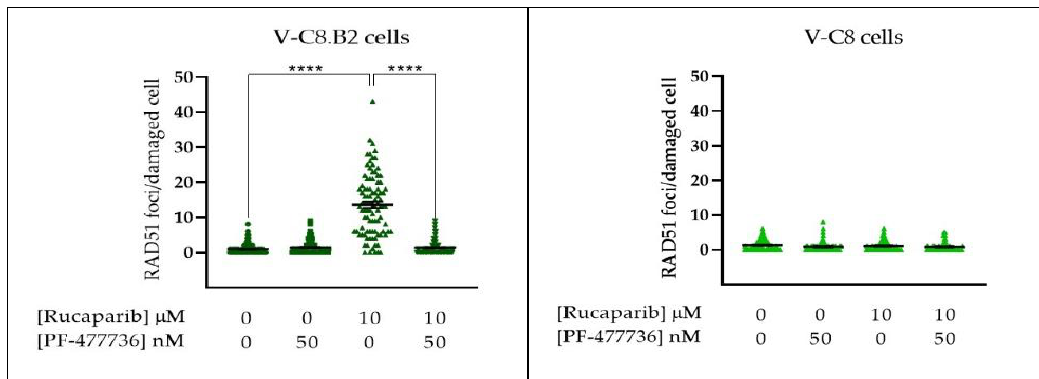
Figure 4. Impact of PF-477736 on cell cycle and homologous recombination repair (HRR) in rucaparib-treated cells. Cells were exposed for 24 h to DMSO, rucaparib, or rucaparib with PF-477736 at the indicated concentrations. ( a ) Cell cycle analysis of V-C8.B2 cells; data are from a single experiment. ( b ) Representative images are shown above quantified γ H2AX and RAD51 foci, where each data point represents a single nucleus. RAD51 foci were only counted in cells with > mean γ H2AX foci in untreated cells. Data are pooled from three independent experiments.